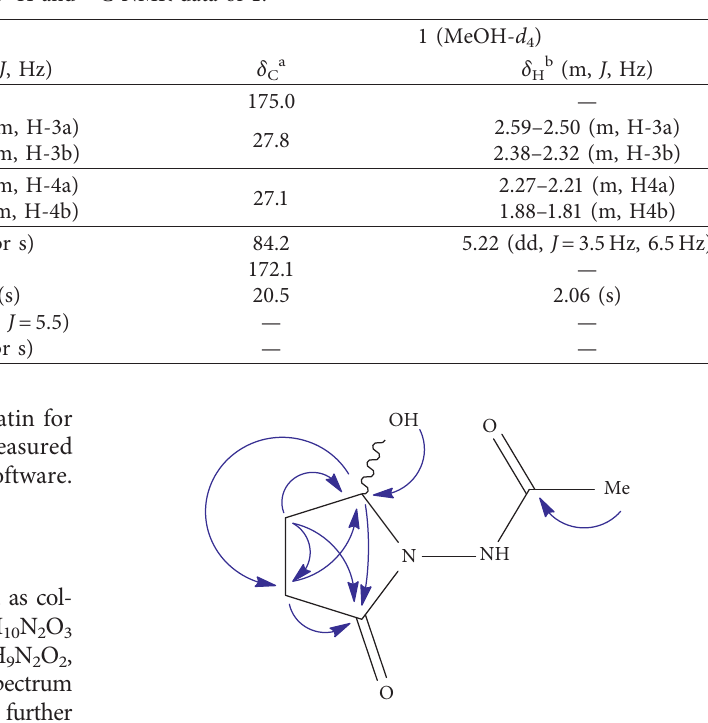
Figure 2: Key HMBC correlations of the new compound 1